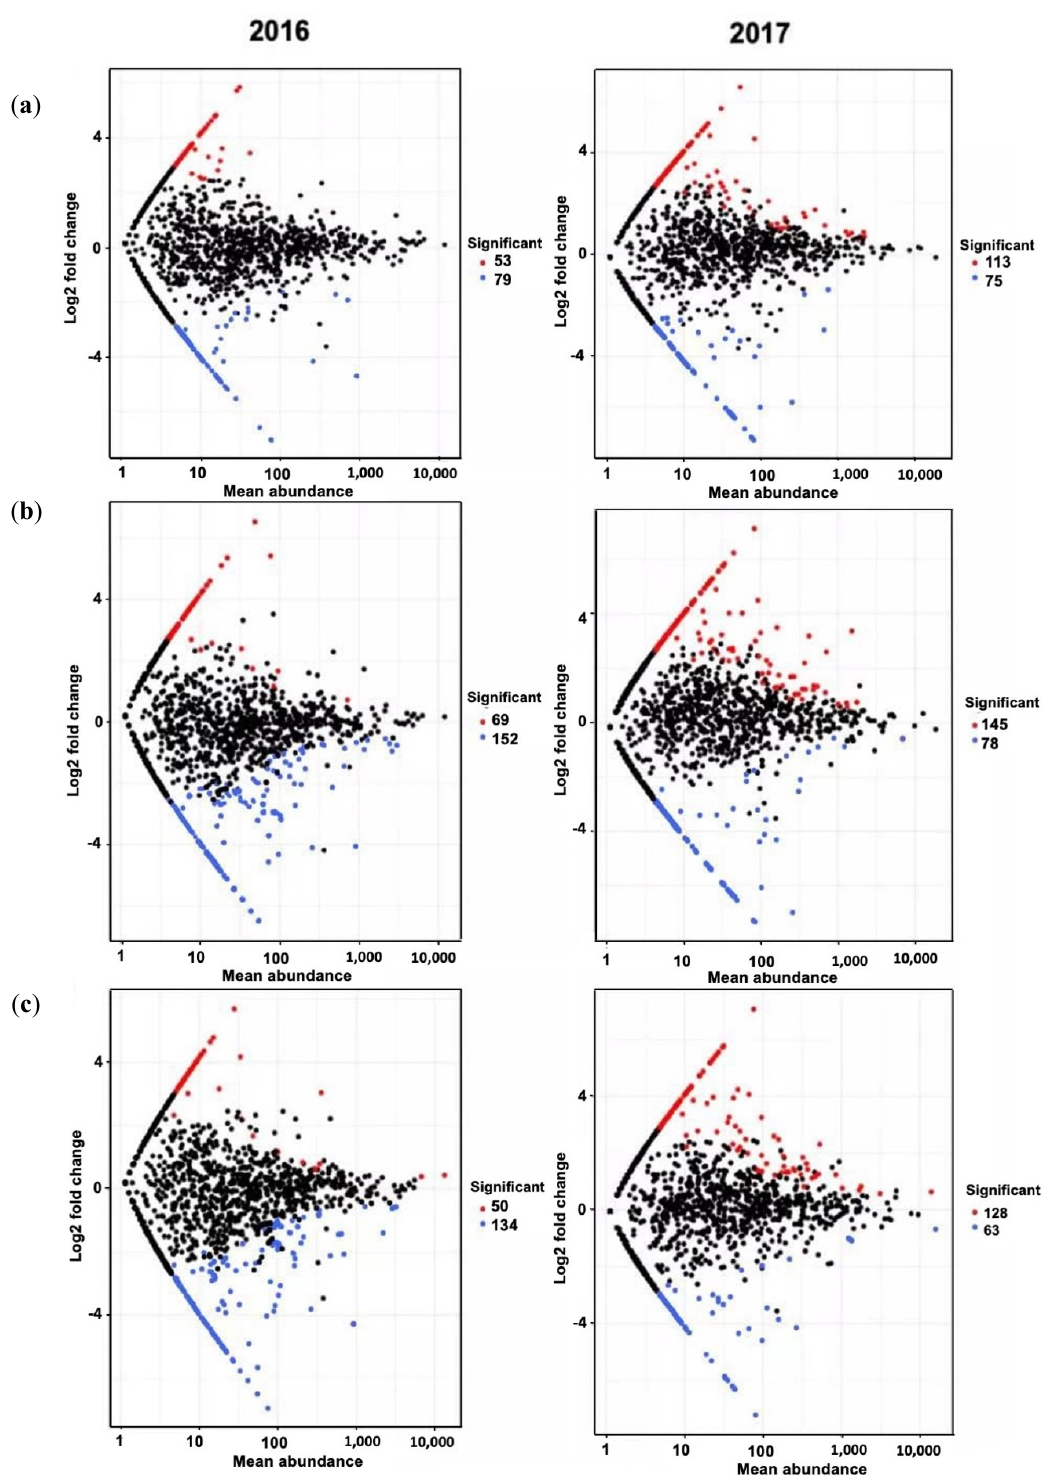
Figure 4. Mean abundance plots illustrating ASVs significantly enriched (red) and depleted (blue) by soil treatment. Volcano plots compared with untreated control as determined by differential abundance analysis. Each point represents individual ASVs, and the Y axis indicates the abundance fold change vs. control. ( a ) BC-treated soil vs. control; ( b ) PL-treated soil vs. control; ( c ) BC/PL-treated soil vs. control in 2016 and 2017, respectively.